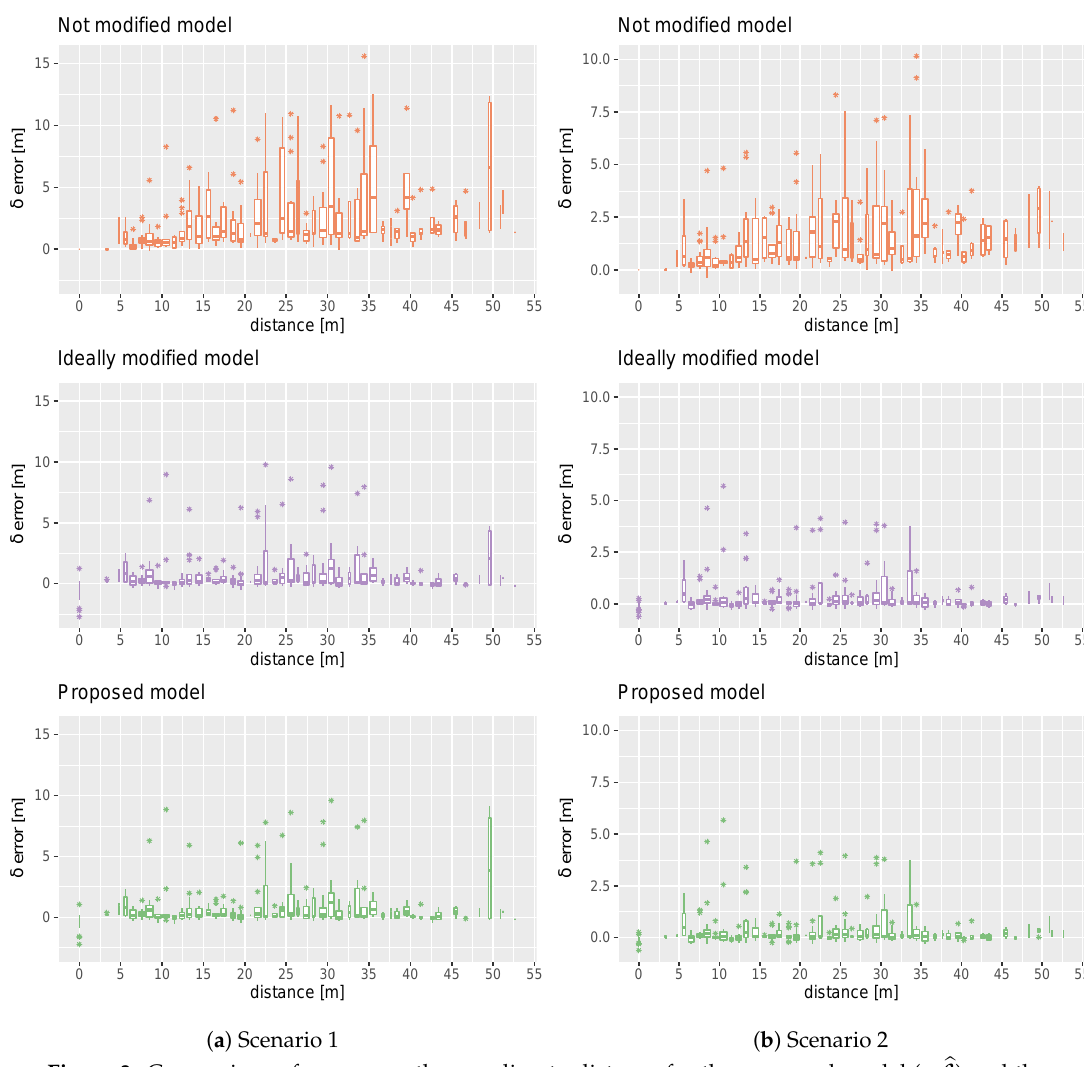
Figure 3. Comparison of error growth according to distance for the proposed model ( m reference models without modification (